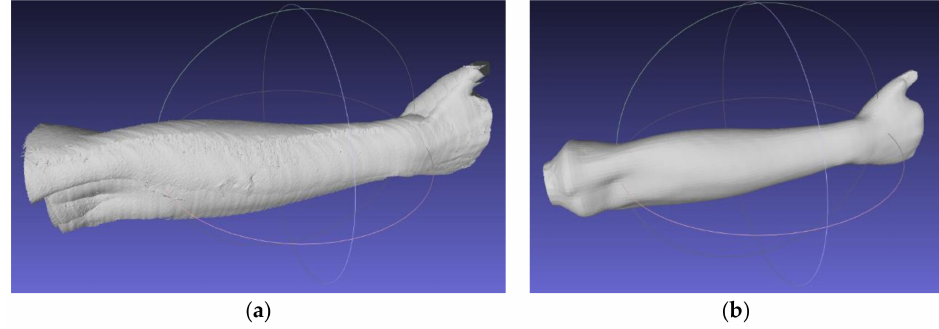
Figure 4. Obtained forearm geometry. ( a ) Raw meshes after merging and cleaning; ( b ) result of screened Poisson surface reconstruction algorithm.